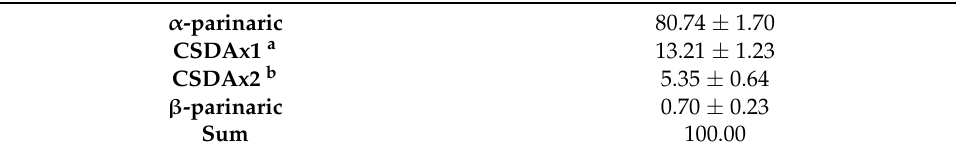
Table 6. 18:4 Isomer distribution found for Impatiens b. Entries are percentages of total integrated 18:4 FID signal and are the means of three independent determinations. Uncertainties are 95% confidence limits based on the t -distribution with 2 degrees of freedom. α -parinaric is the FAME of 9 c ,11 t ,13 t ,15 c -18:4. β -parinaric is the FAME of 9 t ,11 t ,13 t ,15 t